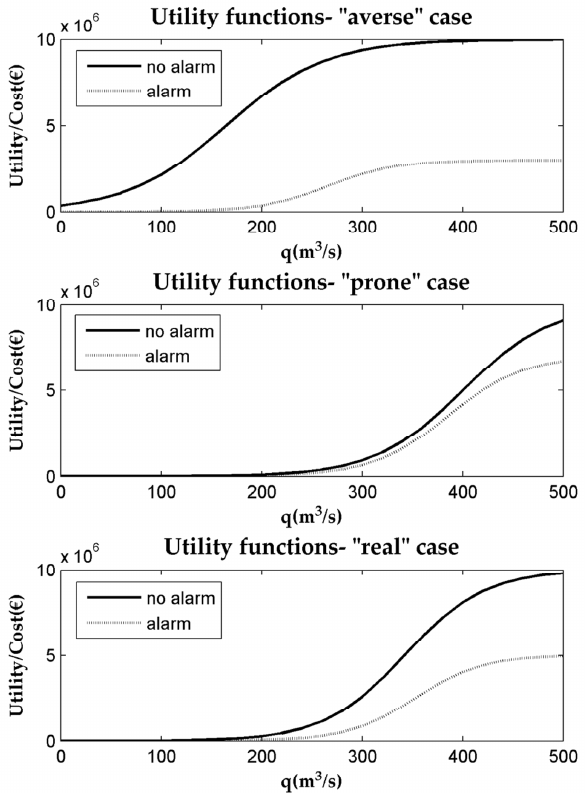
Fig. 1. Utility functions for different risk cases. The dotted line represents the function if the alert is issued, the solid line if